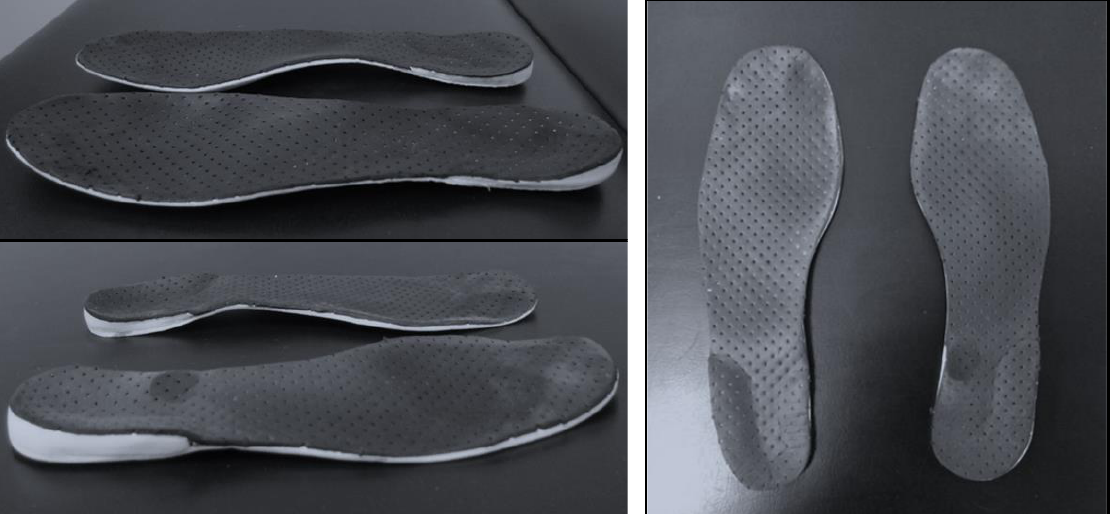
Figure 4. Custom orthopedic insole (total-contact with wedge at the side edge of the heel) combined with minimalist shoes for six months of intervention.